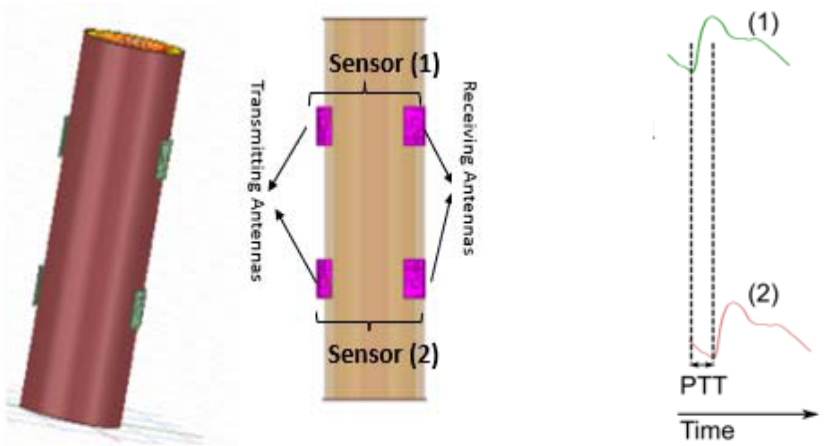
Figure 14. Two pairs of transmitting and receiving antennas bent over a cylindrical multi-layer human arm model developed in ANSYS HFSS. Electromagnetic waves leaving the antennas can reach the targeted brachial artery along with the wide dielectric characterization range. L = length from the first sensor to the second; PTT = time taken for the pulse wave to propagate from: (1) the upper side; to (2) lower side of the brachial artery. Based on the methodology of this study, the PWV-PPT relationship was noted for three distinct cases reflecting the effect of blood flow, and thus, blood pressure estimation. The cases were investigated with different artery h/R ratios of 0.5, 0.7 and 0.9.